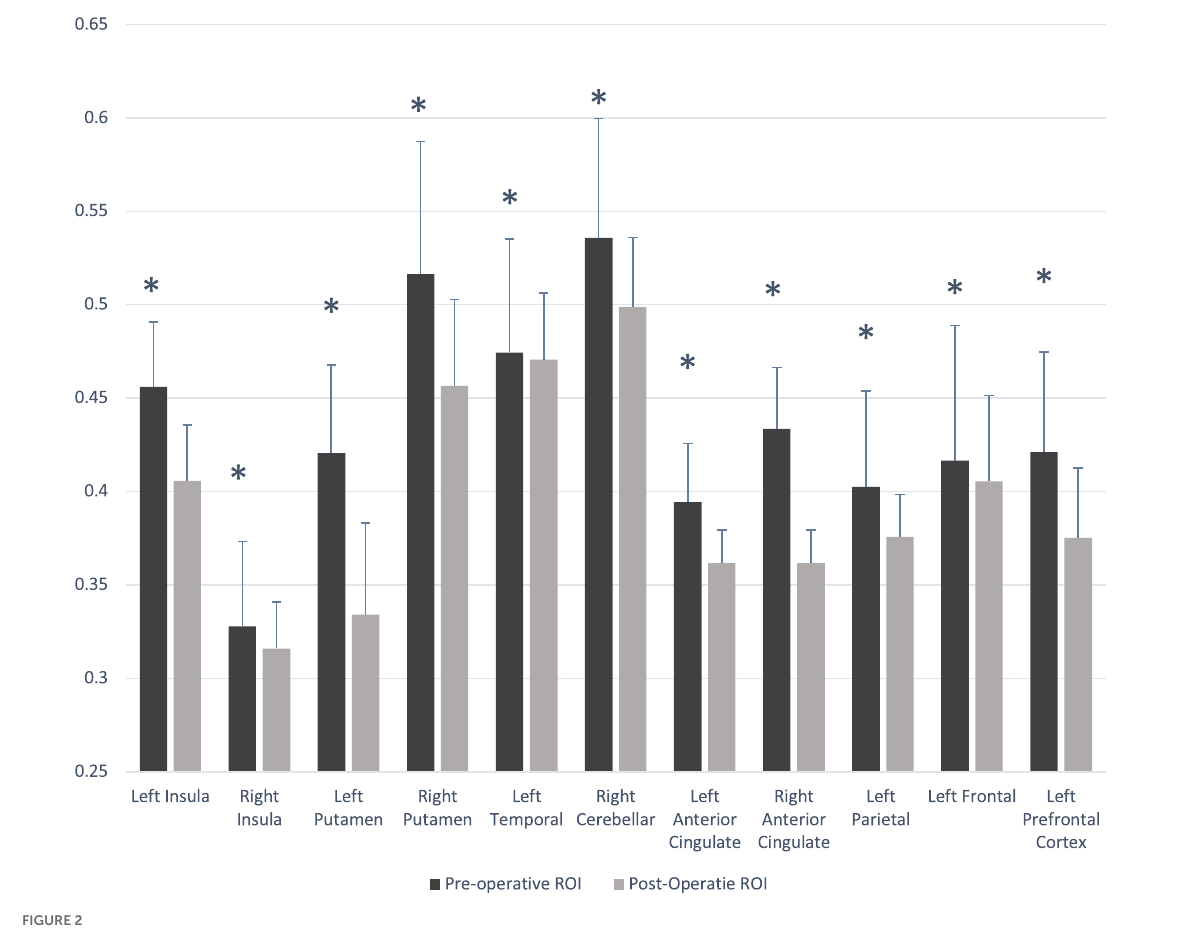
TABLE 3 Regional brain gray matter volume values ( n = 8, mean ± SD, mm 3 ) from pre- and post-lung transplant patients. Brain regions Pre-operative Post-operative P -values